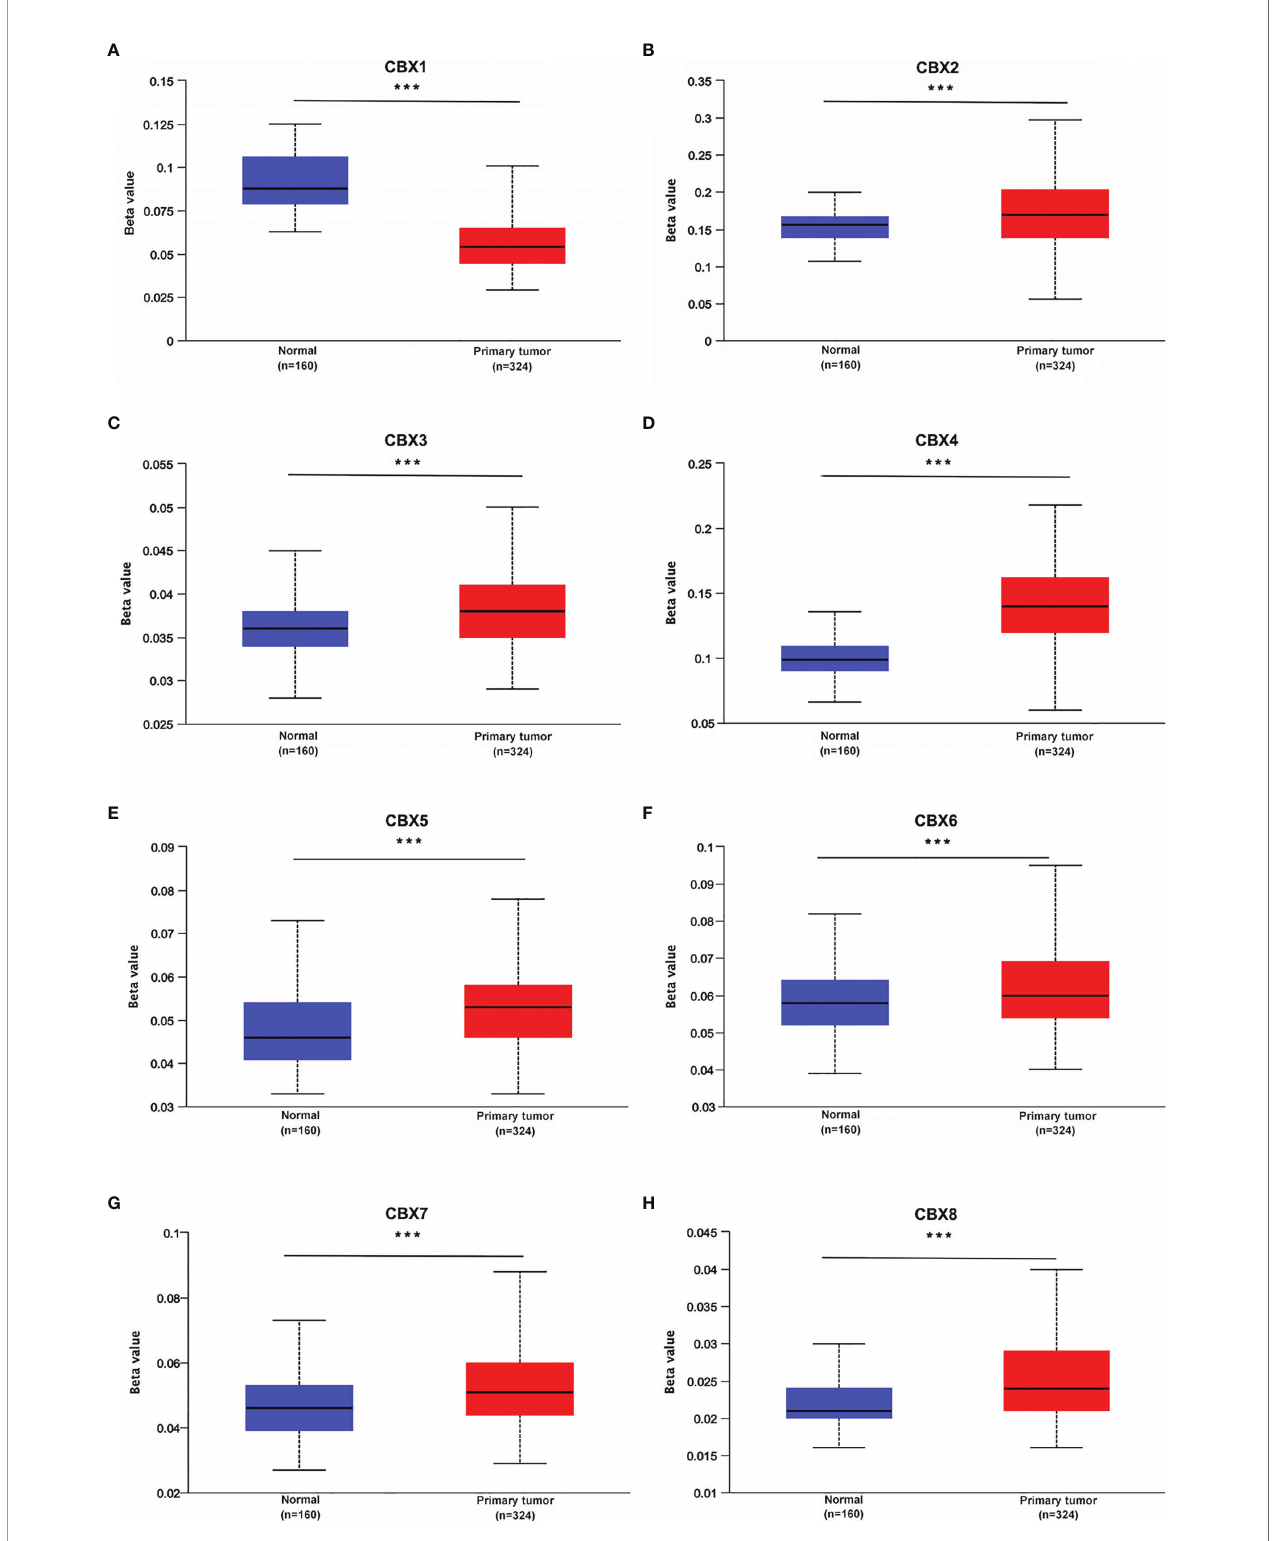
FIGURE 7 | Promoter methylation status of CBXs in ccRCC (UALCAN). The promoters of CBX2, CBX3, CBX4, CBX5, CBX6, CBX7 and CBX8 were hypermethylated in ccRCC tissues (B – H) , while CBX1 promoter was hypomethylated in ccRCC tissues than that in normal kidney tissues (A) . (*** P <0.001).